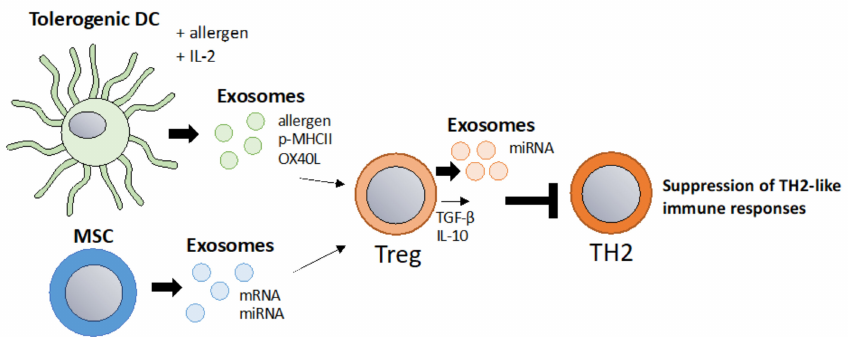
Figure 3. Tolerosomes derived from DCs, IEC or MSC to induce allergen tolerance via Tregs. A main goal in allergy immunotherapy is the induction of regulatory T cells. Exosomes derived from IL-2 primed tolerogenic DCs were shown to promote regulatory T cells [98]. Additionally, MSC derived exosomes promote regulatory T cells [96]. As Tregs suppress TH2 responses via IL-10, TGF-b and via exosomes, Treg-derived exosomes themselves could be harnessed to suppress TH2 responses [53].